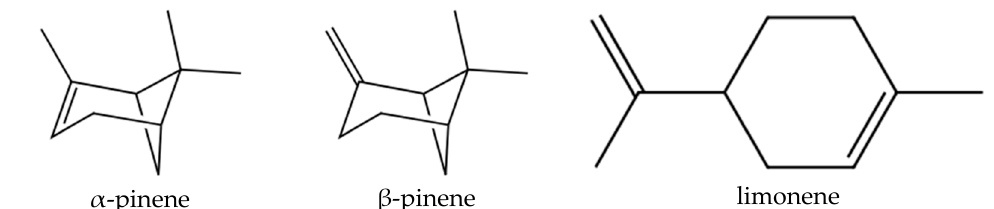
Figure 6. Some constituents of Juniperus